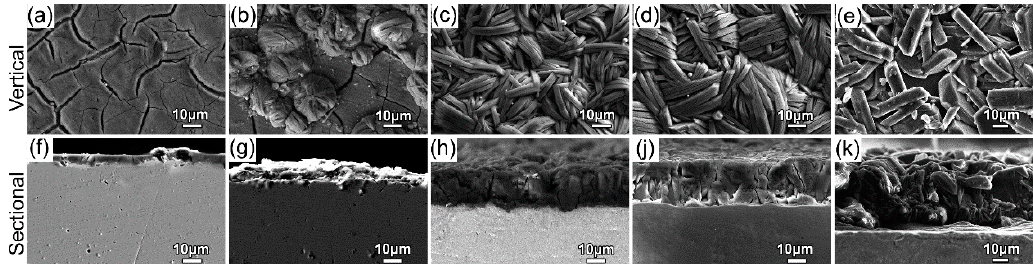
Figure 2. Secondary electron imaging (SEI) images showing FeS coating morphology evolution with increasing temperature: ( a , f ) 30 °C; ( b , g ) 40 °C; ( c , h ) 50 °C; ( d , j ) 70 °C; ( e , k ) 90 °C.